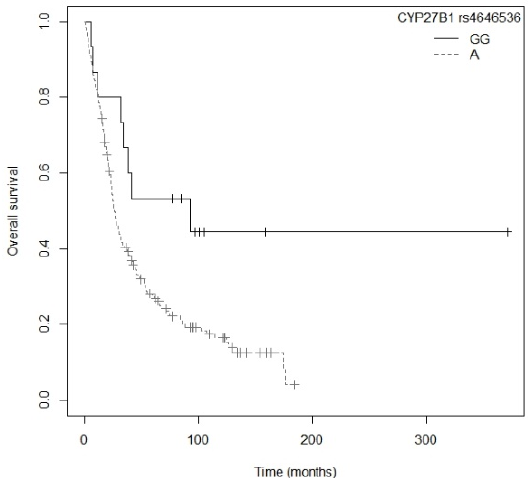
Figure 2. Kaplan–Meier plot of overall survival curves with the A allele of the CYP27B1 rs4646536 gene polymorphism in 194 patients with NSCLC. Table 3. Influence of gene polymorphisms and clinical characteristic on overall survival of 194 NSCLC patients.